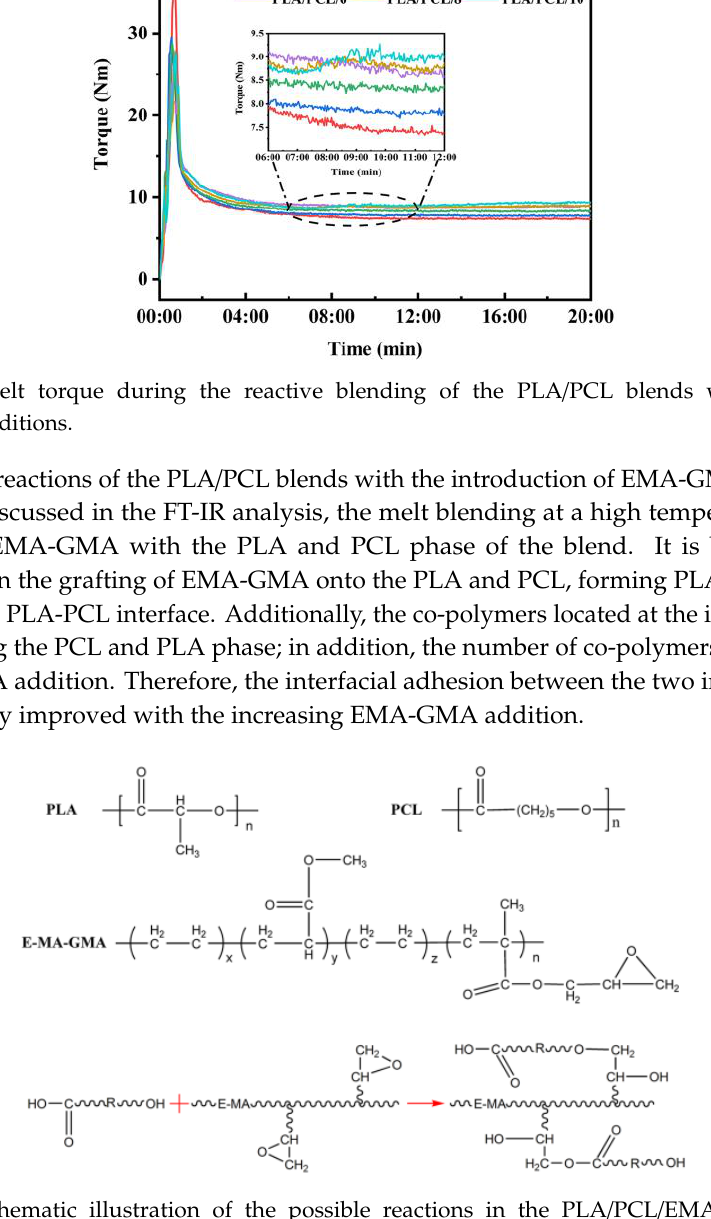
Figure 3. Schematic illustration of the possible reactions in the PLA/PCL/EMA-GMA blend (“R” represents PLA or PCL).